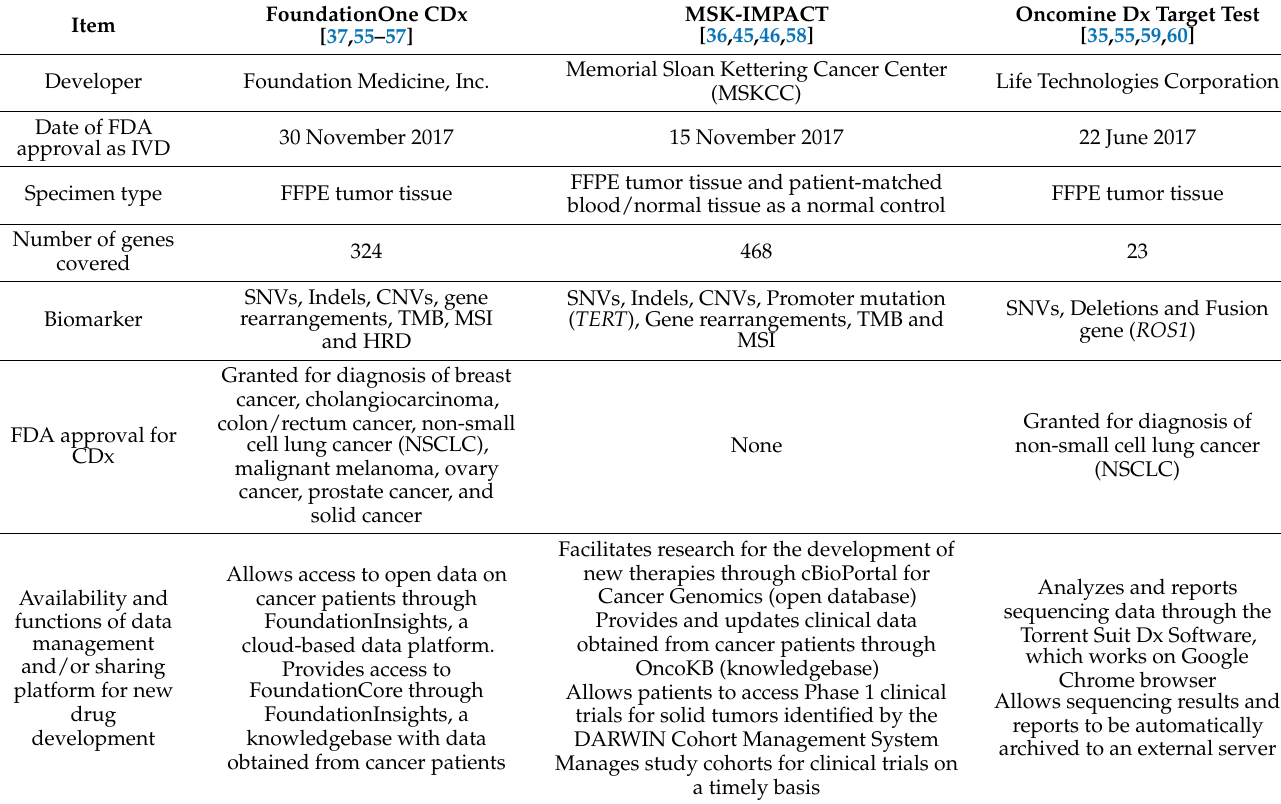
Table 2. Comparison of basic information.